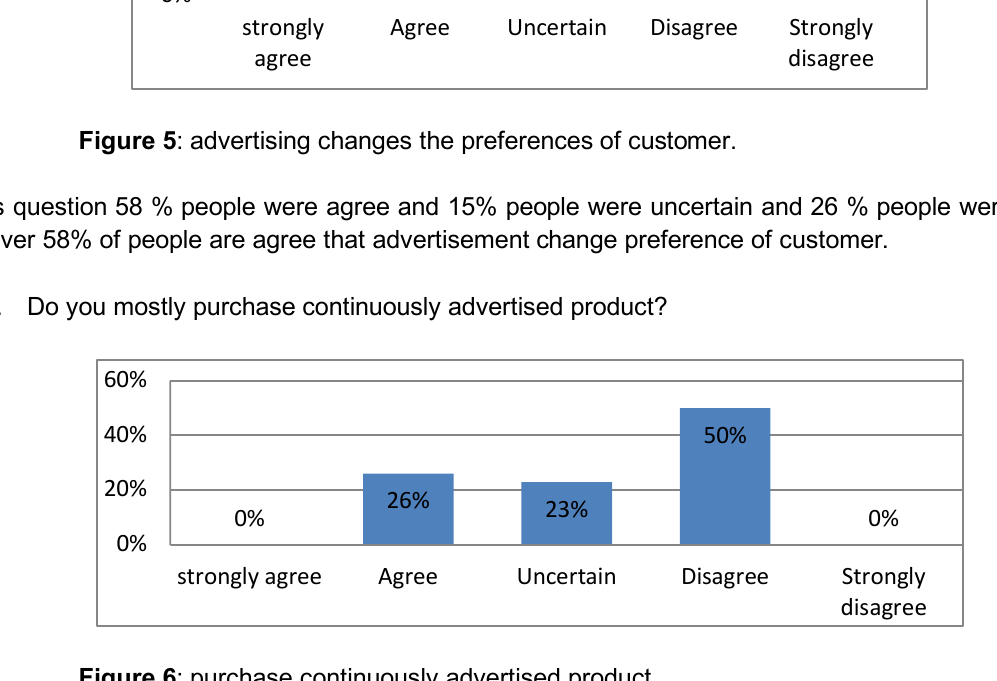
Figure 6 : purchase continuously advertised